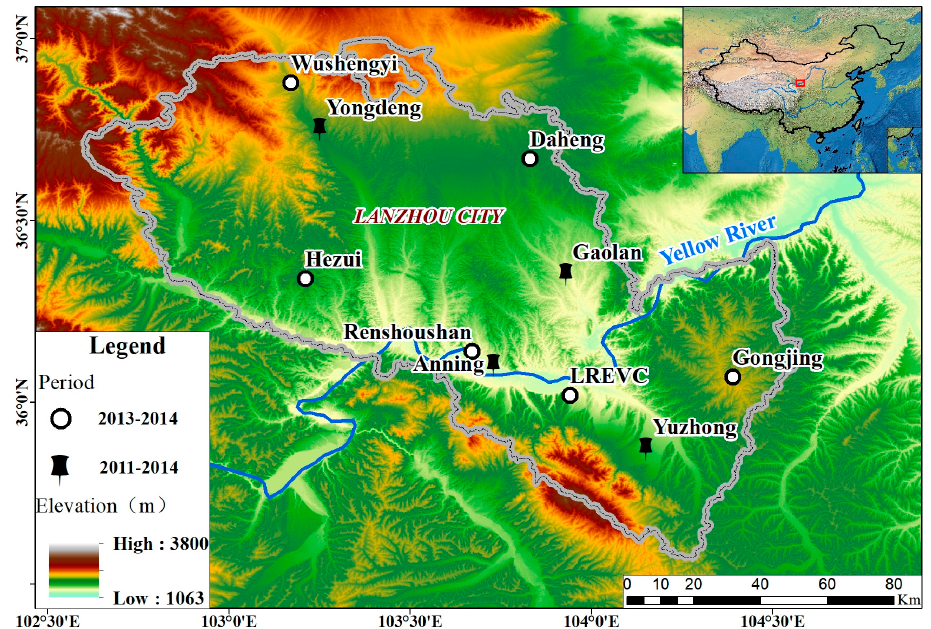
Figure 1. Map showing the four stations (Anning, Yongdeng, Gaolan and Yuzhong marked as black pins) in the Lanzhou city, China. The stations involved in Chen et al. [33] but not included in this study are also marked as white circles. The small map indicates the location of the Lanzhou city in China.